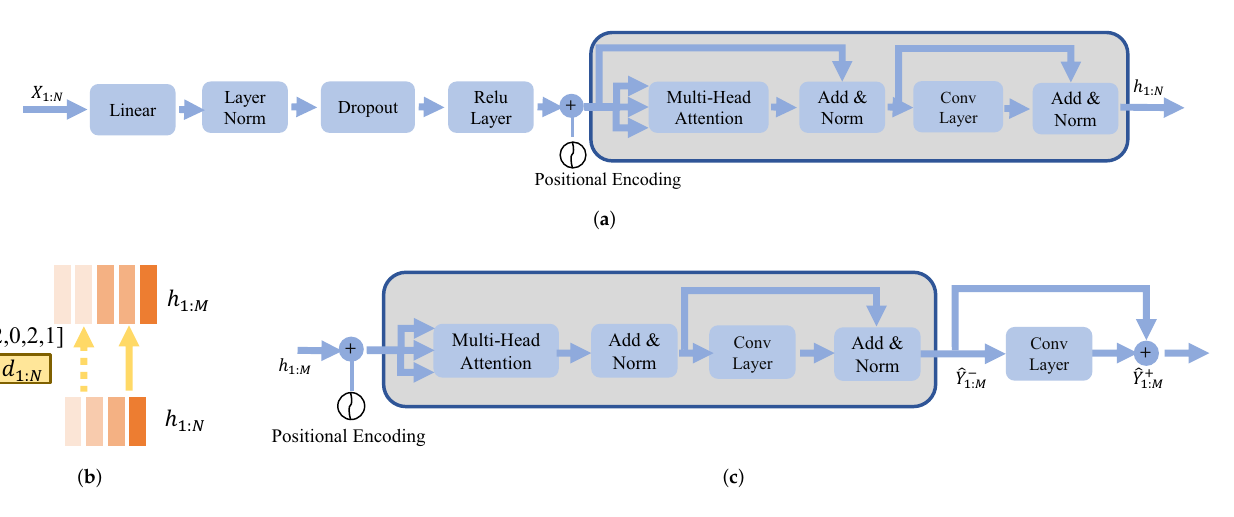
Figure 4. Illustrations of model details about the source encoder, length regulator, and the target decoder. ˆ Y + and ˆ Y − are the mel-spectrograms predicted before and after the postnet. The gray 1: M 1: M blocks represent the FFT module. ( a ) Source encoder, ( b ) length regulator, ( c ) target